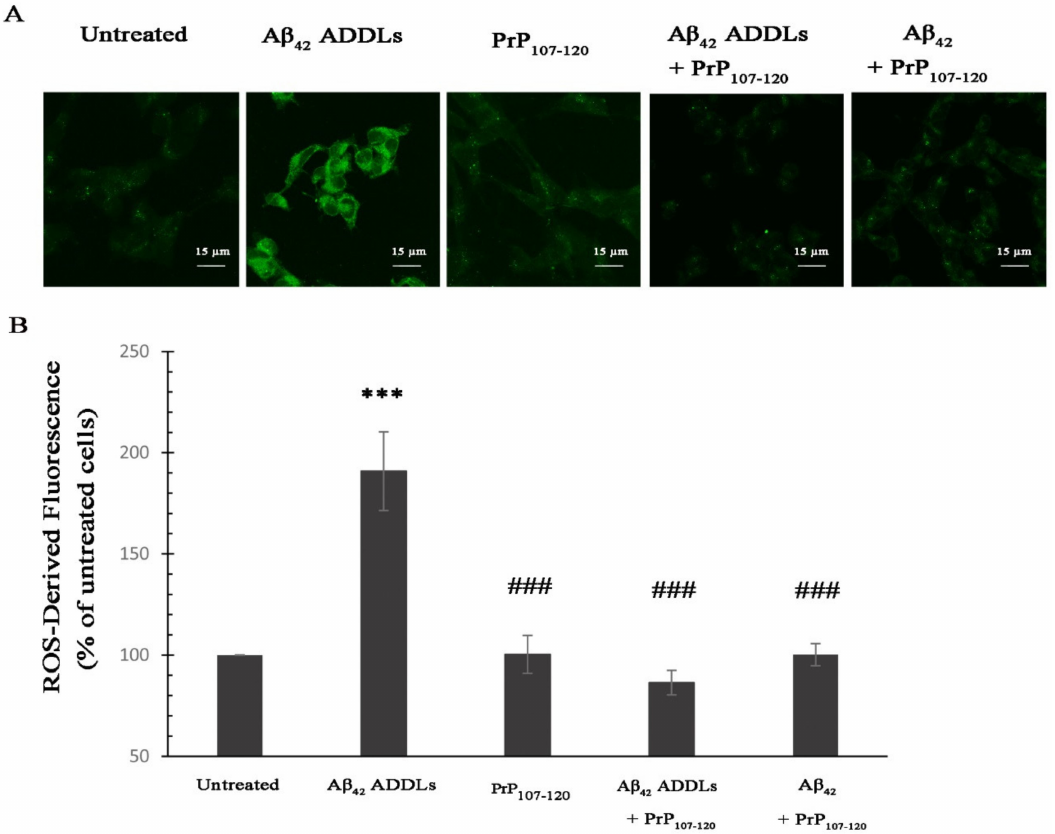
Figure 5. Analysis of intracellular reactive oxygen species (ROS) levels of SH-SY5Y cells treated with A β 42 oligomers and PrP 107–120 . ( A ) Representative scanning confocal microscopy images of intracellular free ROS levels in SH-SY5Y cells loaded with CM-H 2 DCFDA. The cells were treated with the same samples described in the Figure 4 legend. Scale bar = 15 µ m. ( B ) Semi-quantitative analysis of intracellular ROS-derived fluorescence. Experimental errors are S.E.M. ( n = 3). The triple (***) asterisks refer to p values < 0.001 relative to the untreated cells. The triple (###) symbols refer to p values < 0.001 relative to A β 42